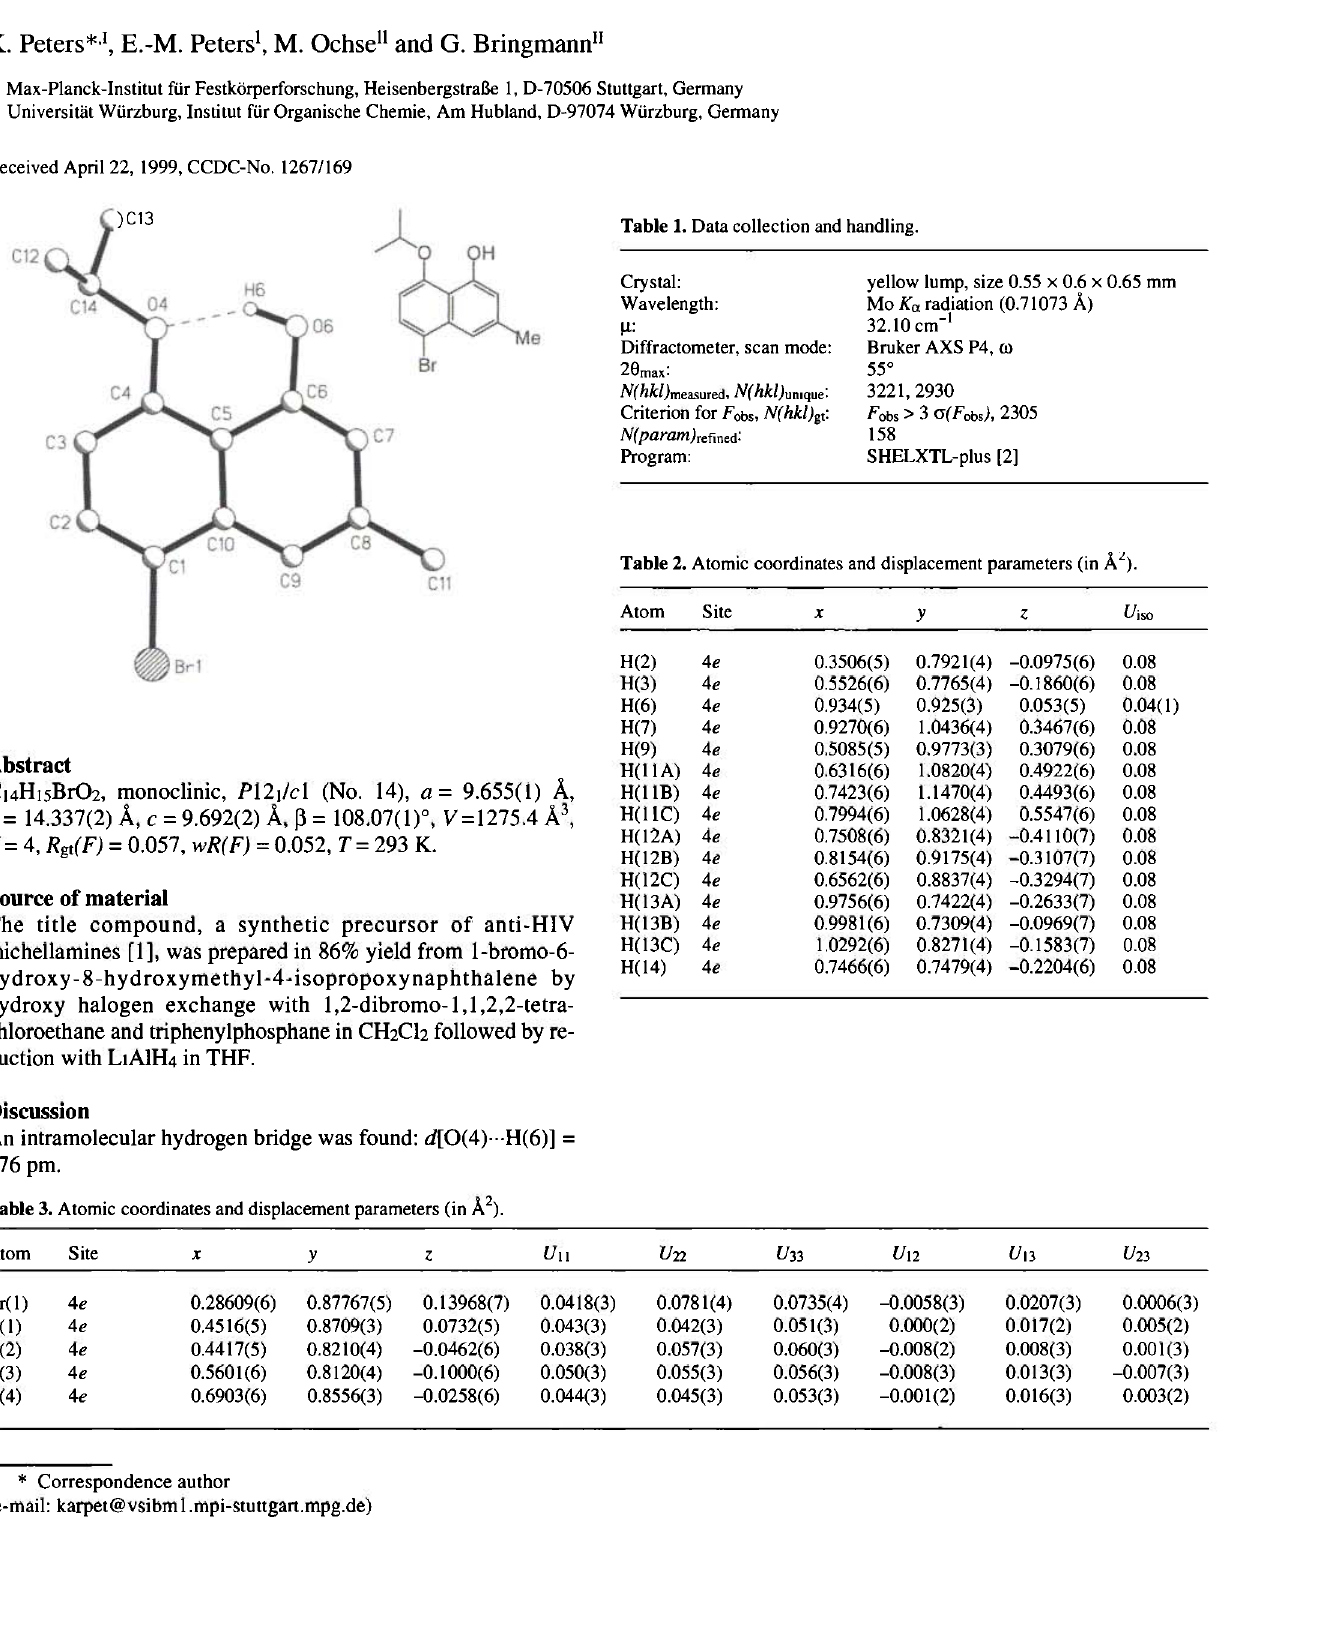
Table 1. Data collection and handling. Crystal: